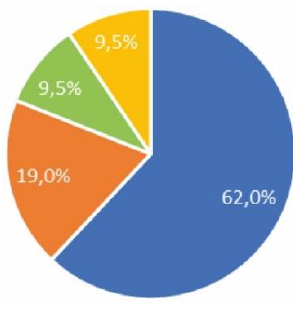
Figure 8. Health survey.